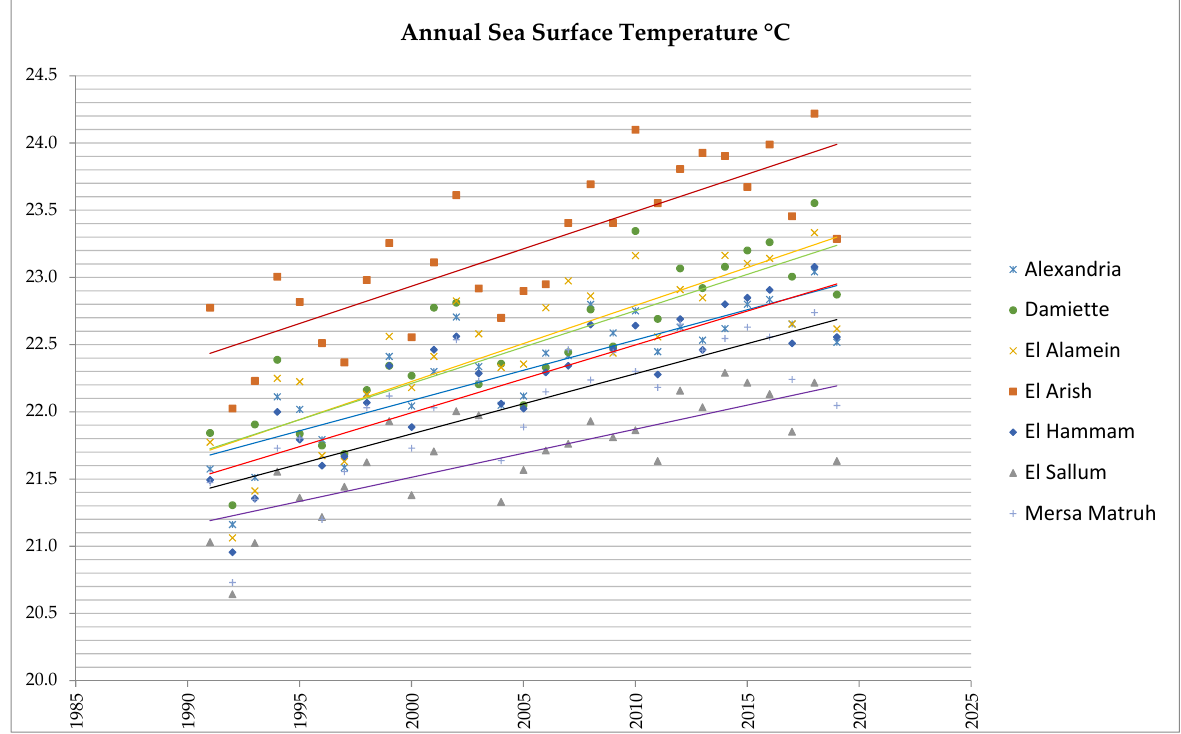
Figure 4. Sea surface temperature and trend lines obtained through Sen slope estimator in El-Arish, Alexandria, Mersa Matruh, and El-Sallum and in additional stations such as Damiette, El-Hammam, and El-Alamain.